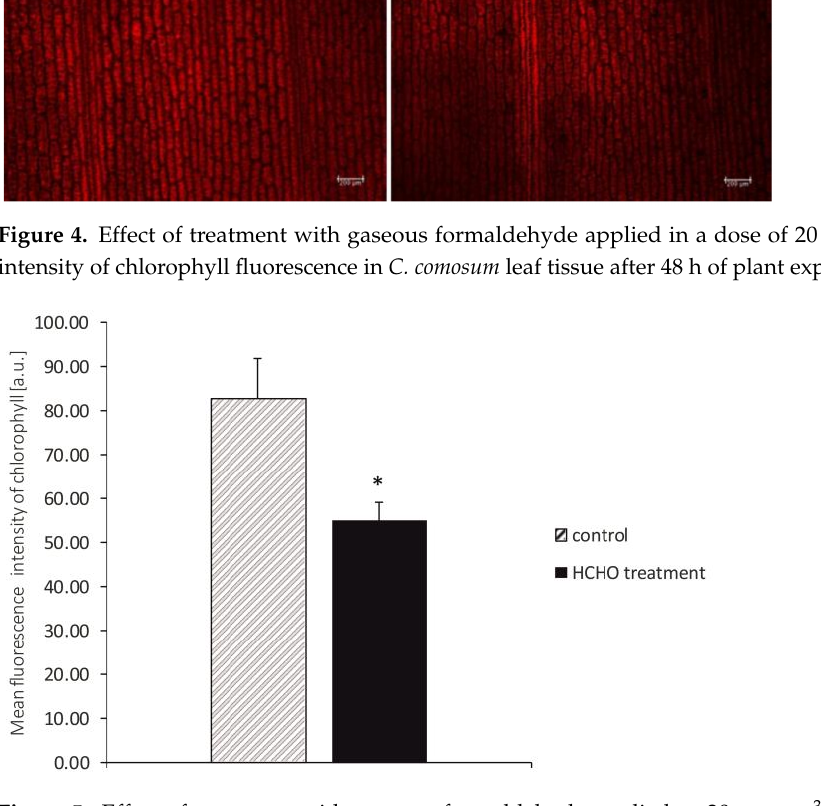
Figure 6. Effect of treatment with gaseous formaldehyde applied as 20 mg m − 3 on total phenolic content in C. comosum leaf tissues after 48 h of plant exposure. The data are means ± SD. 4. Discussion The results of the present studies showed that C. comosum might effectively partici- pate in the removal of HCHO from the air. Since the initial concentration of HCHO oscil- lated around 20 mg m − 3 , and after 48 h of plant exposure it decreased to 0.02 mg m − 3 , we could suppose that most of the formaldehyde loss in the chamber could be attributed to plant foliar uptake. A non-significant change in HCHO concentration in C. comosum leaves might suggest its effective metabolism by the plants. Moreover, even though the high con- centration of HCHO was used, no visible harmful effects of this compound were detected in plant leaves. The results confirmed the previous findings that spider plants have a very strong capacity to remove formaldehyde from the air [2]. Moreover, Jian Li et al. [46] showed that C. comosum had the strongest resistance to formaldehyde as compared to other varieties of this species.